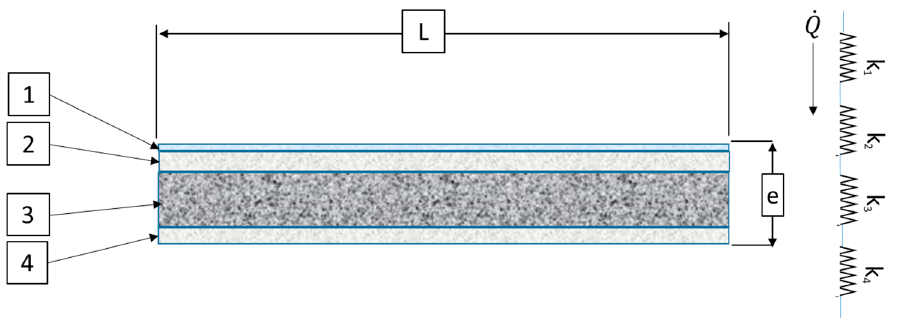
Figure 2. Typical building roof section.